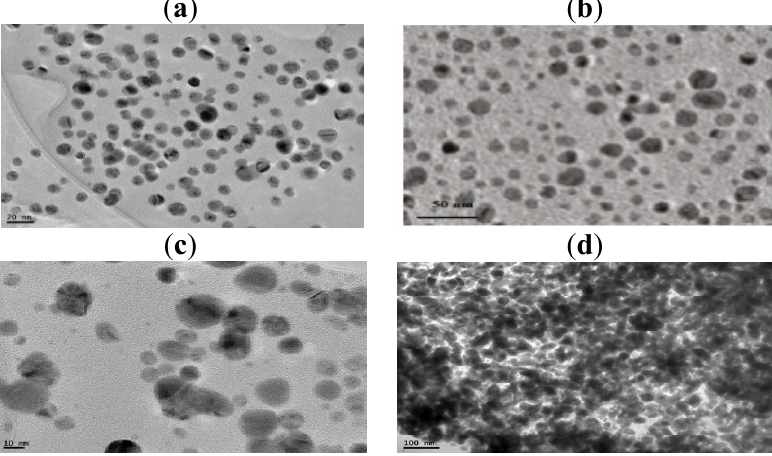
Figure 8. TEM image of Ag NP ( a ) coated with PVA-SH, after exposure to 1 M HCl and 0.4 M of glycine ( b ) for 1 week, ( c ) for 3 months and ( d ) citrate Ag NP after exposure to 0.1 M HCl for 1 h.